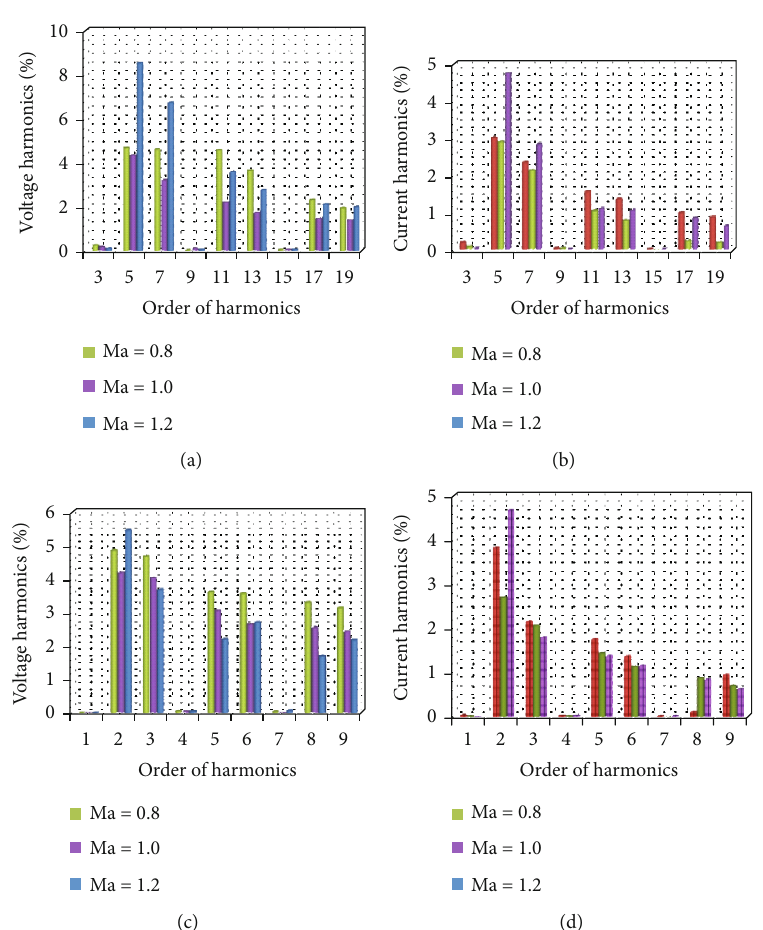
Figure 10: (a) Harmonic analysis of rated output voltage. (b) Harmonic analysis of load current. (c) Harmonic analysis of output voltage of 120V. (d) Harmonic analysis of load current for 120V output voltage system.